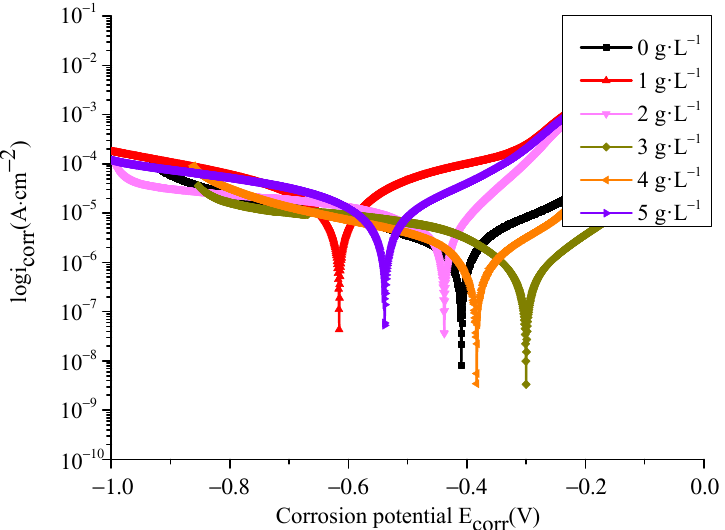
Figure 10. Potential polarization curves of coatings prepared by scanning electrodeposition on 45 steel substrates with different particle concentrations. Table 5. Corrosion electrochemistry parameters of coatings with different particle concentrations prepared on 45 steel substrates through scanning electrodeposition.